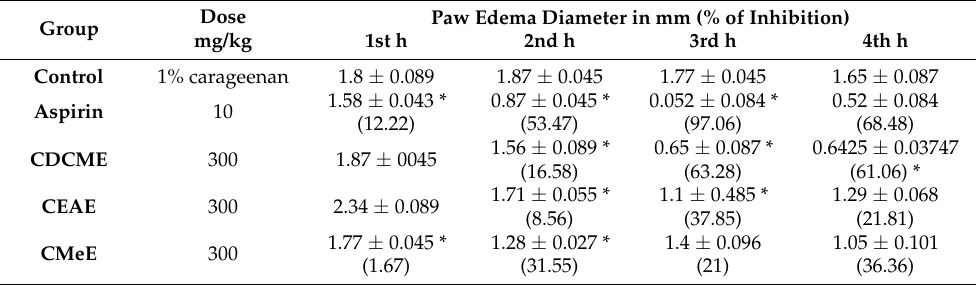
Table 4. Effect of Oldenlandia corymbosa L. extracts on the carrageenan induced